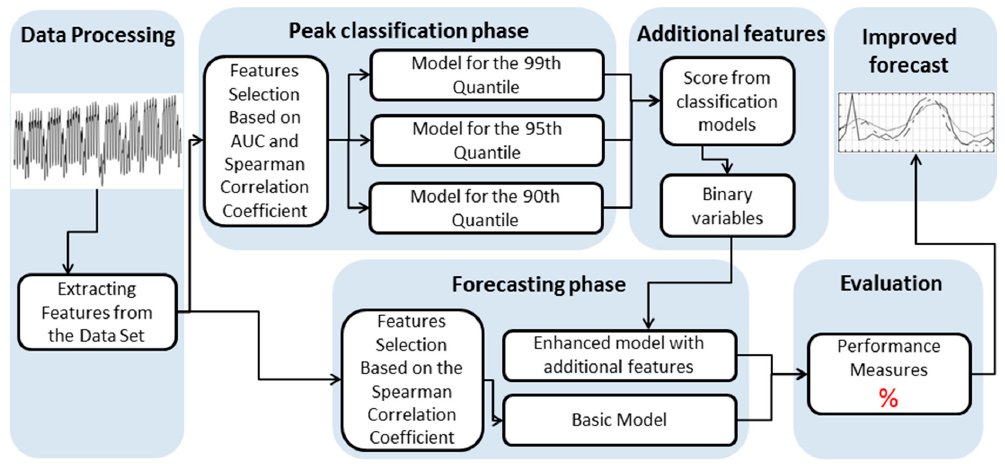
Figure 5. Design of the two-stage modeling approach.